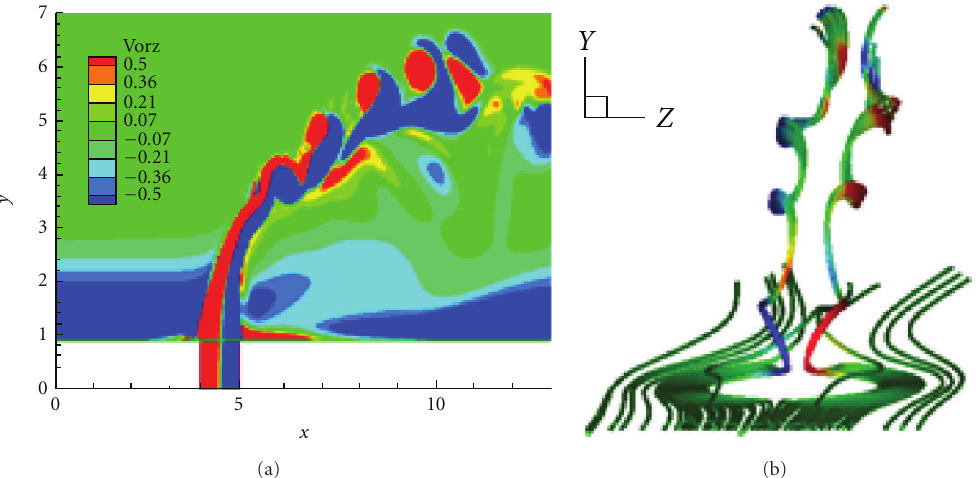
Figure 2: Normal single square jet in cross-flow. (a) Contours of spanwise vortices ω z on a vertical plane and (b) 3D streamlines showing formation of Kelvin-Helmholtz vortex